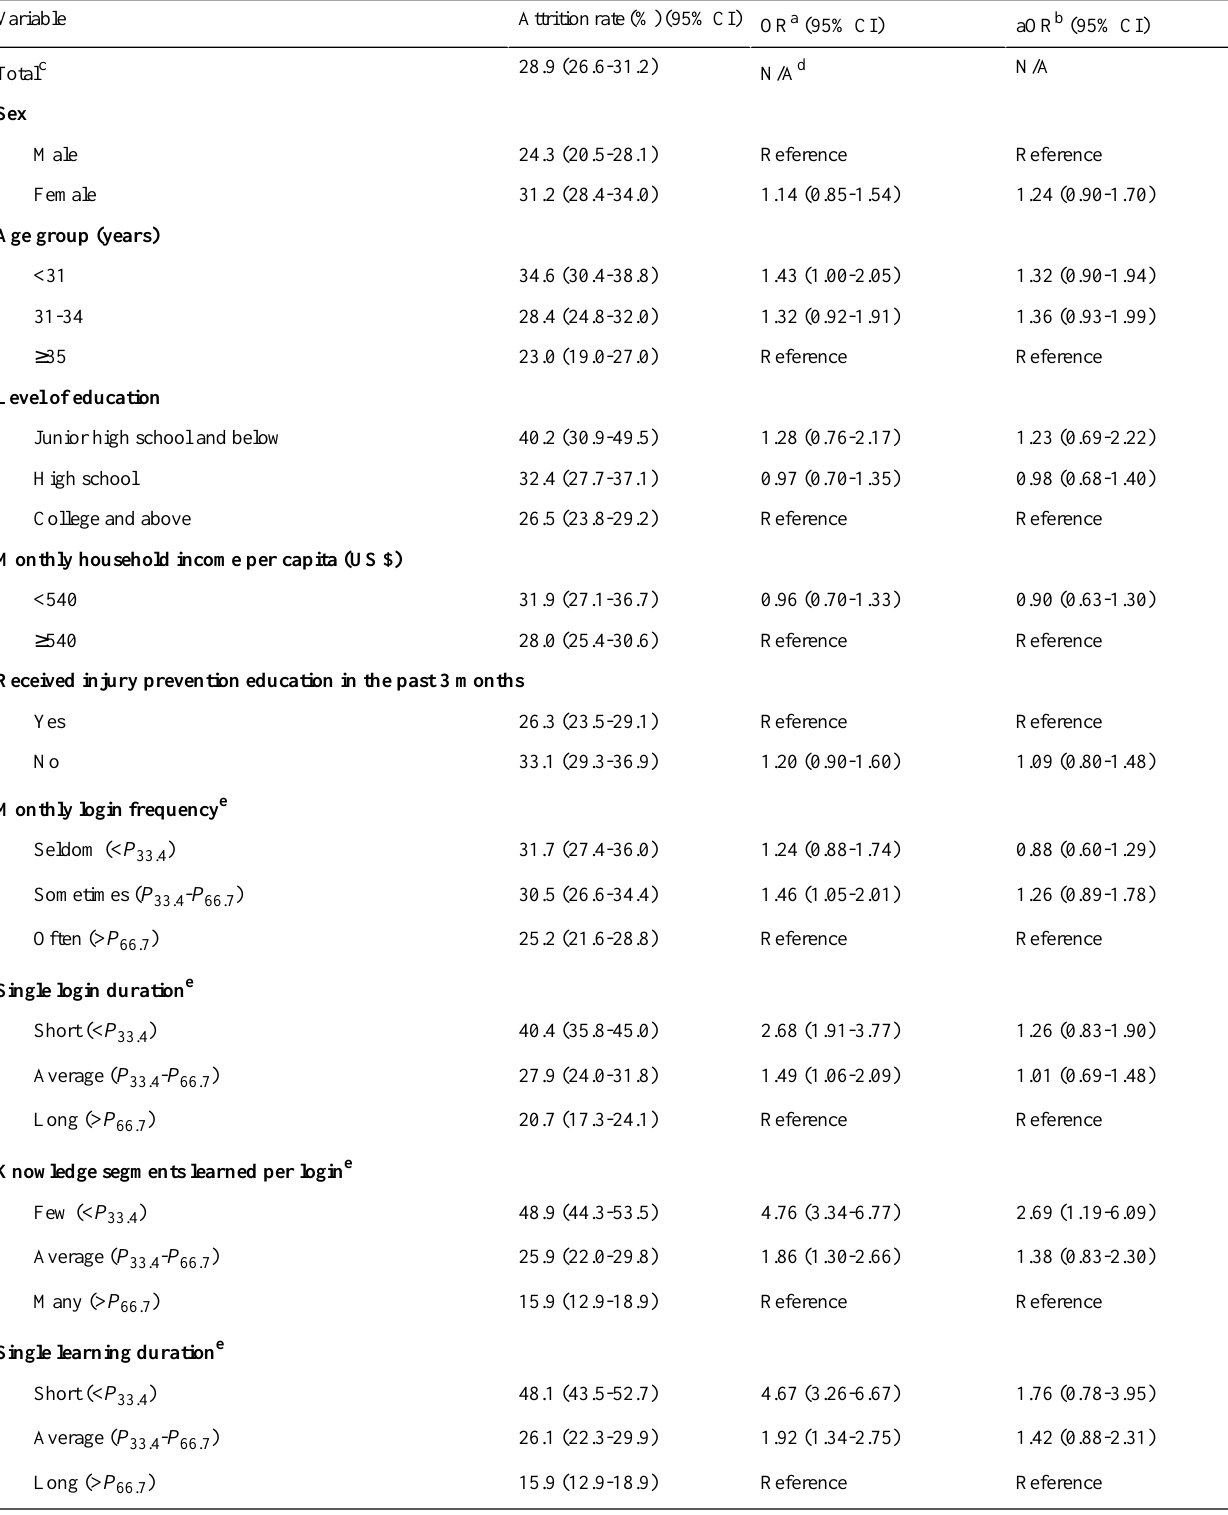
Table 3. Six-month attrition rates of caregivers of preschoolers in the intervention group